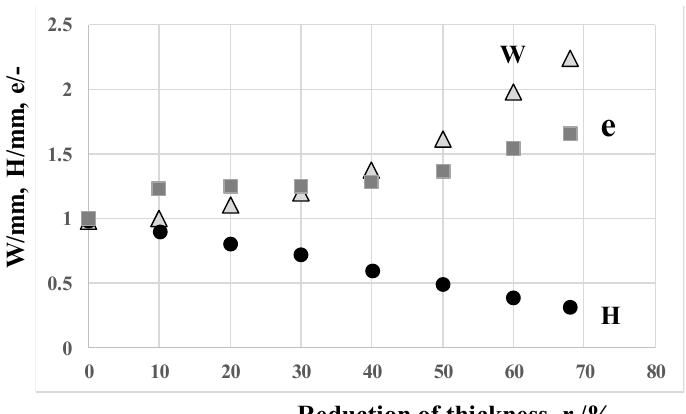
Figure 6. Variation of the titenium wire thickness (H), the width (W) and the surface aea extension rate (e) with increasing the reduction of